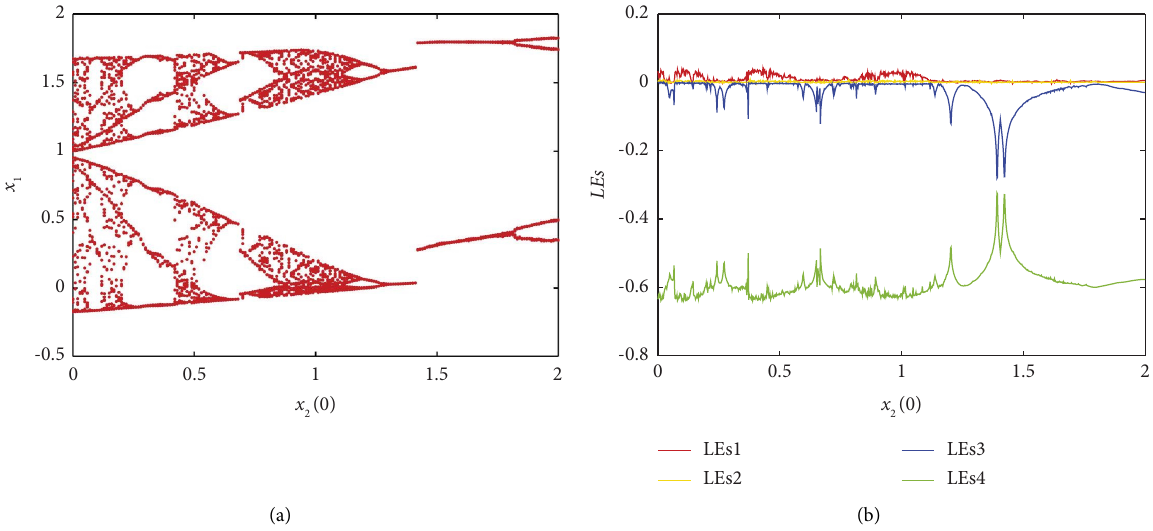
Figure 9: Initial value x